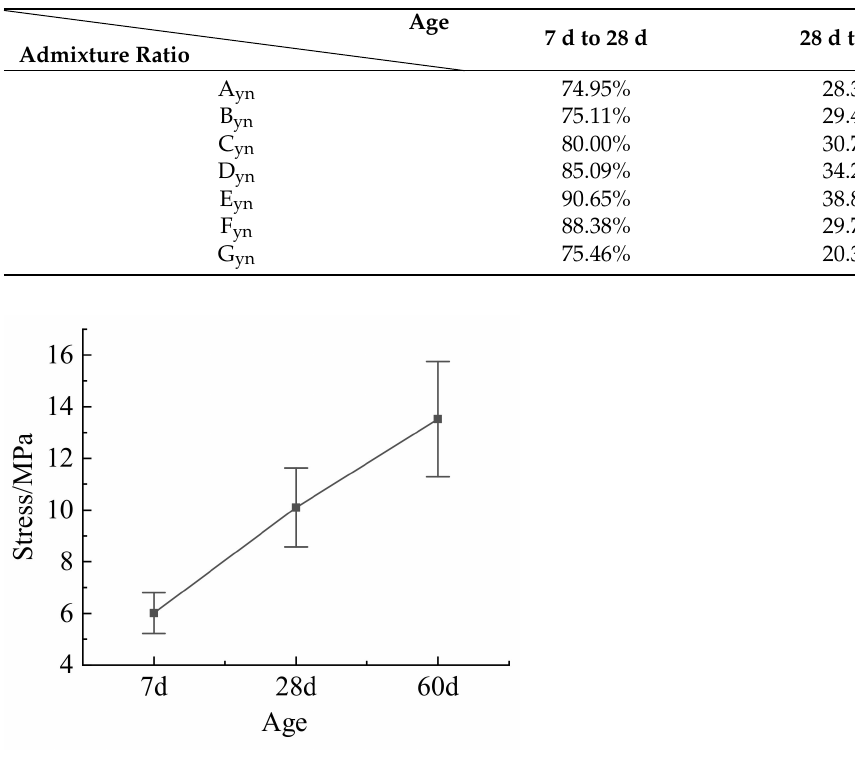
Figure 4. The error